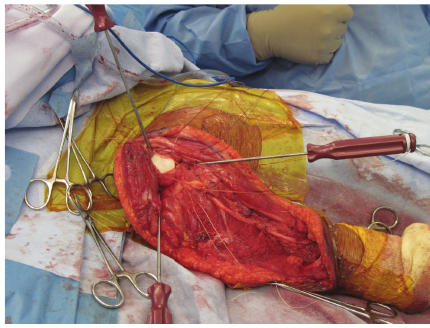
Figure 7: Placement of suture anchors about glenoid neck.